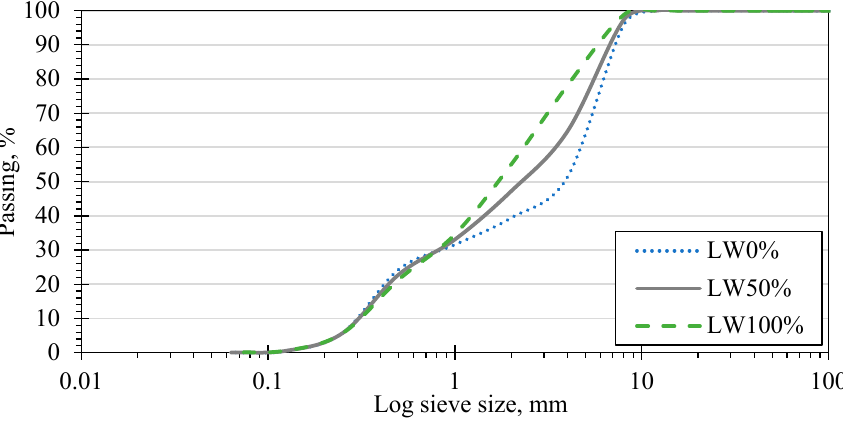
Figure 1. Sieve analysis for produced aggregate blends.